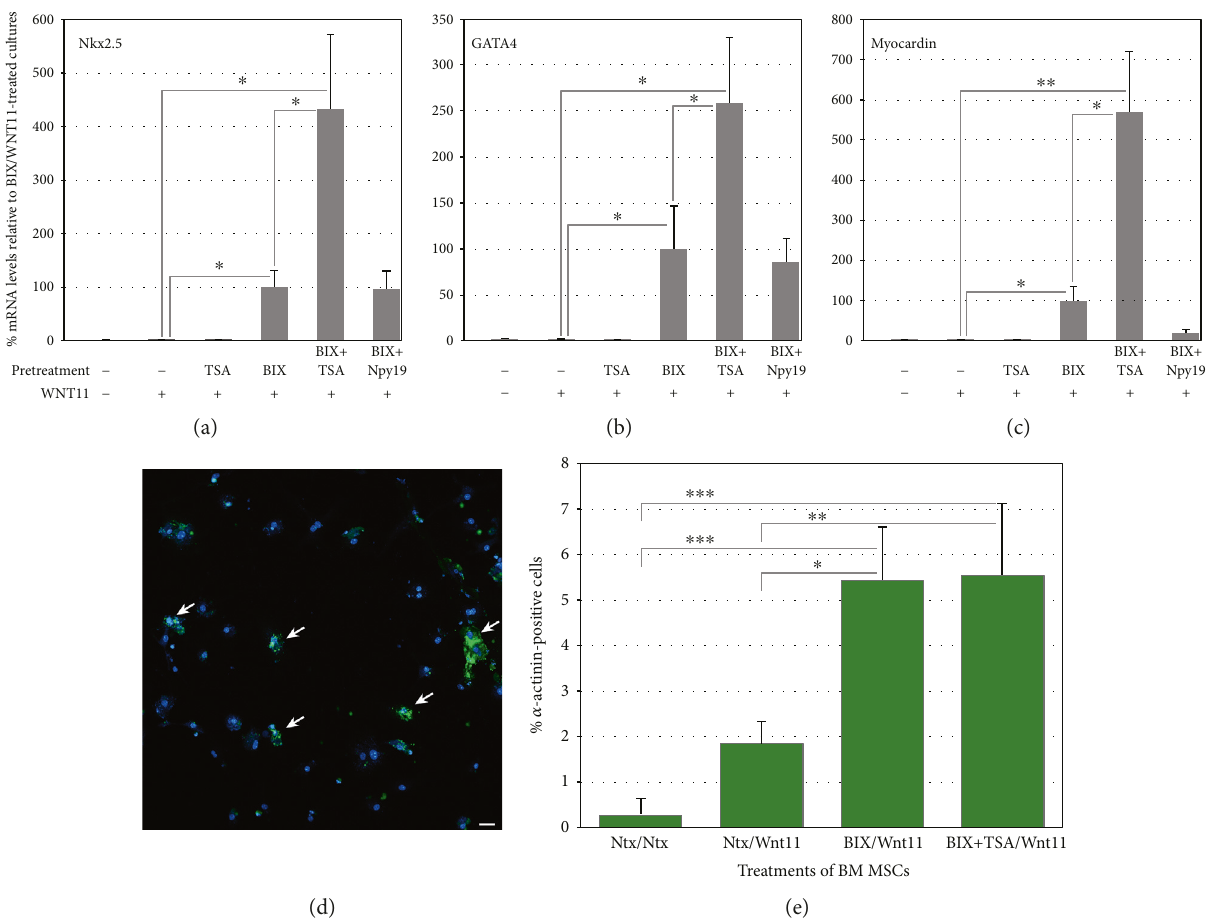
Figure 3: TSA coaddition with BIX01294 promotes greater responsiveness to the cardiogenic stimulating factor Wnt11. MSCs were cultured in the absence or presence of 8 μ M BIX01294 plus or minus either 50 nM TSA or 1 μ M Npy19 for 48 hrs, prior to seven-day culture in fresh media with or without Wnt11. (a) – (c) Real-time qPCR analysis of RNA harvested from the cultures indicates that the primary cardiac transcription factors Nkx2.5, GATA4, and myocardin were signi fi cantly upregulated in MSCs in response to Wnt11, but only when pretreated with BIX01294. When TSA (but not Npy19) was combined with BIX01294 during the initial 48 hr incubation period, a signi fi cant enhancement was observed for Nkx2.5 ( n = 11 ), GATA4 ( n = 11 ), and myocardin ( n = 8 ) of 4.3-, 2.6-, and 5.6-fold, respectively. Statistical signi fi cance is shown for comparative levels of Nkx2.5, GATA4, or myocardin expression displayed by Wnt11 stimulated cultures pretreated with either TSA plus BIX01294 or BIX01294, and nonpretreatment controls ( ∗ p < 0 05 ; ∗∗ p < 0 01 ). (d) Identi fi cation of individual sarcomeric α -actinin positive cells (arrows) by immuno fl uorescent staining indicated that cardiac protein expression within the MSC cultures was in accordance to the gene expression patterns, as shown in this panel for cultures treated sequentially with TSA plus BIX01294 followed by Wnt11. Scale bar =25 μ m. (e) Tabulation of α -actinin positive cells within these cultures demonstrated that BIX01294 or BIX01294+TSA pretreatments signi fi cantly increased the number of cardiac protein expressing cells as compared to nontreated or Wnt11 only conditions. Statistical signi fi cance is indicated by ∗ p < 0 05 ; ∗∗ p < 0 01 ; ∗∗∗ p < 0 001